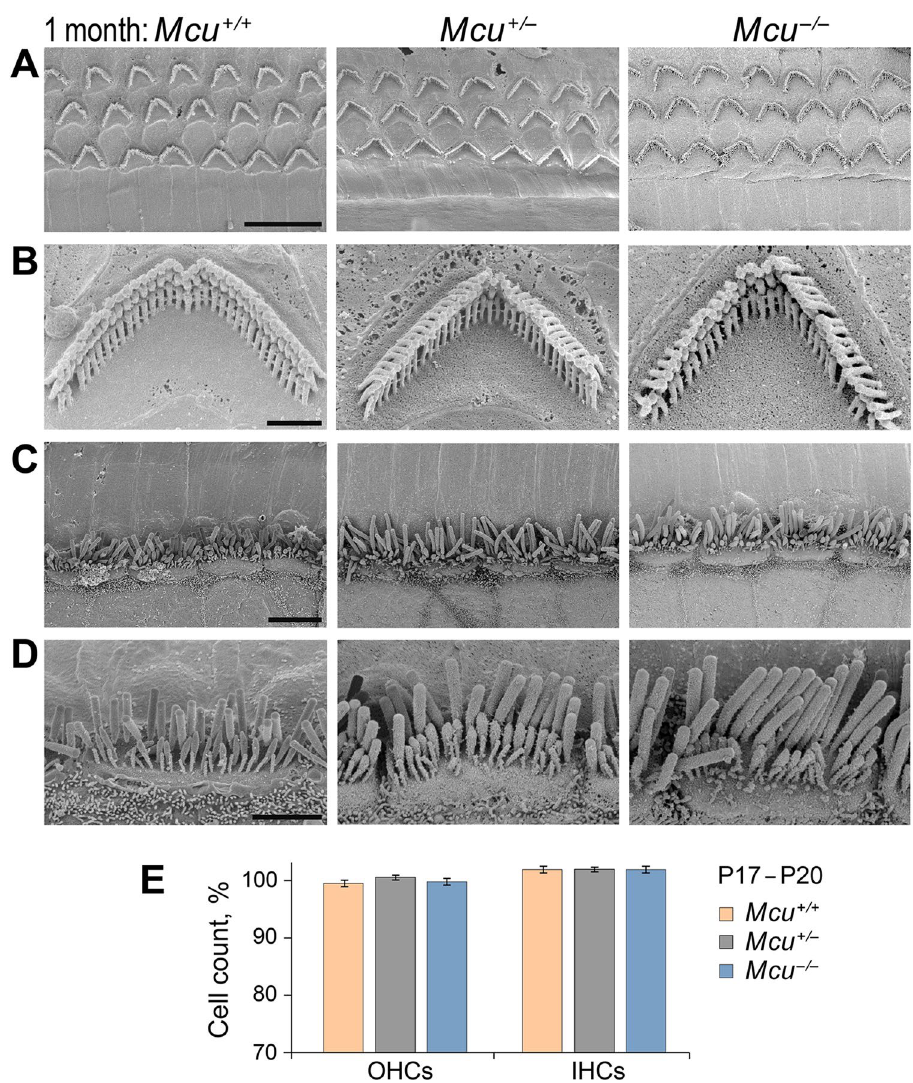
Figure 5. Cochlear hair cells in young FVB/NJ Mcu + / + , Mcu + /− , and Mcu −/− mice. ( A – D ) Representative scanning electron micrographs of cochlear hair cells from 1-month-old FVB/NJ Mcu + / + , Mcu + /− , and Mcu −/− mice. ( A ) The typical three-row arrangement of OHCs, ( B ) single OHC stereocilia at high magnification, ( C ) the single row of IHCs, and ( D ) single IHC stereocilia at high magnification. ( E ) The number of hair cells in the mid-basal cochlear turn at P17–20. Kruskal–Wallis analysis with Dunn’s multiple comparison test did not show any statistically significant differences between groups. The number of mice is 9 ( Mcu + / + ), 21 ( Mcu + /− ), and 9 ( Mcu −/− ). Scale bars are (in µm): 10 ( A ); 1 ( B ); 5 ( C ); 2 ( D